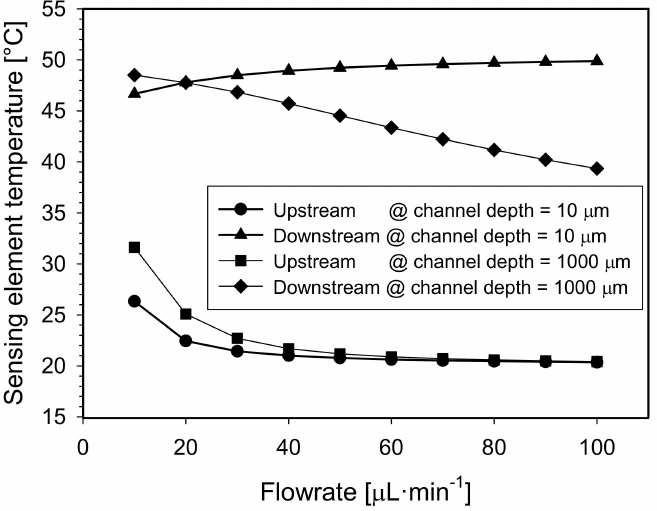
Figure 9. A simulated temperature of the upstream and the downstream sensor element vs. flowrate for two extreme cases of the channel depth (10 µ m and 1000 µ